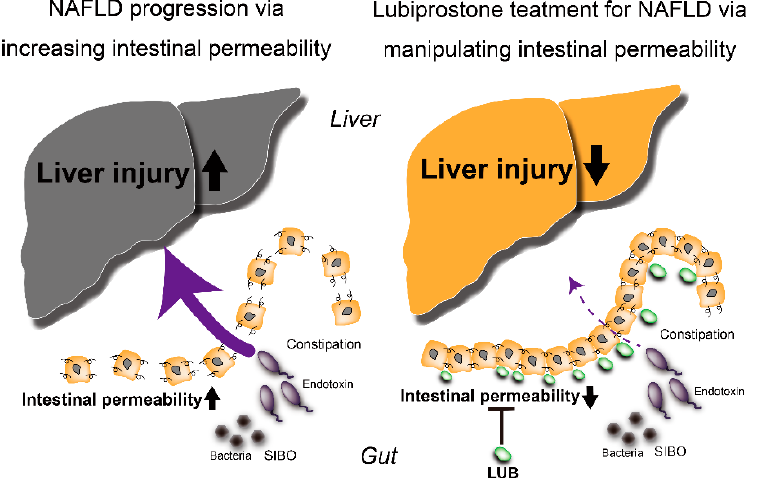
Figure 2. Therapeutic effects of lubiprostone on NAFLD via targeting the intestinal barrier. LUB, lubiprostone; NAFLD, nonalcoholic fatty liver disease; SIBO, small intestinal bacterial overgrowth.